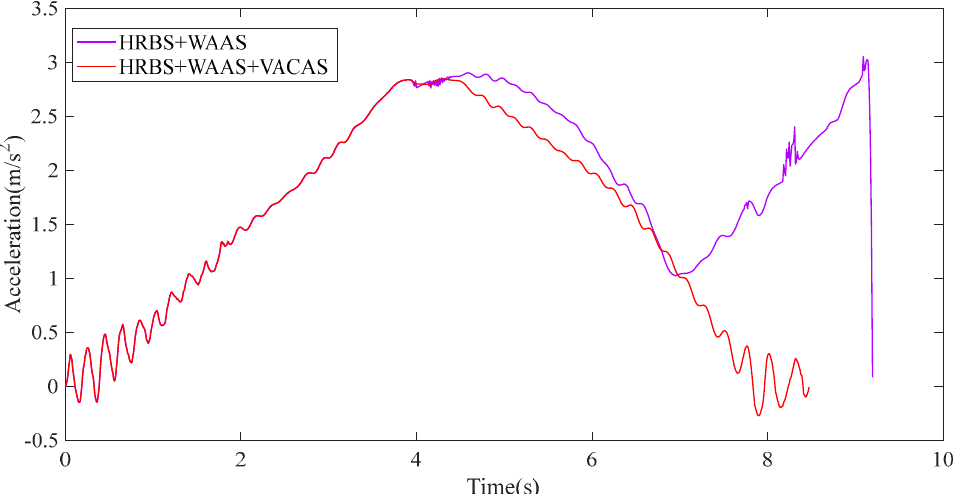
Figure 16. The variation curve of acceleration.